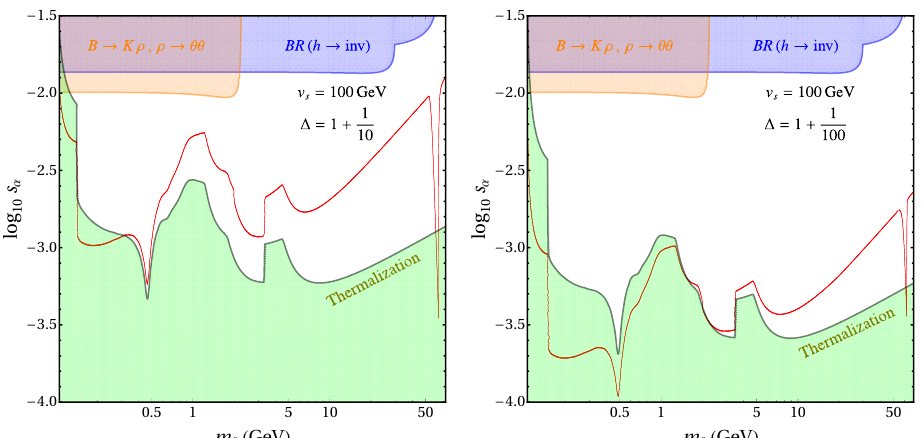
Figure 2. The red line shows the relic abundance in eq. (4.1) for the resonance condition with ρ in the quadratic model. We plot different values of ∆ = 1 + 1 / 10 , 1 + 1 / 100 on the left and right panels respectively, see eq. (4.8), with v = 100 GeV . Experimental constraints from invisible Higgs s decays (blue), rare B meson decays into light scalars (orange) and the thermalization condition (green) are